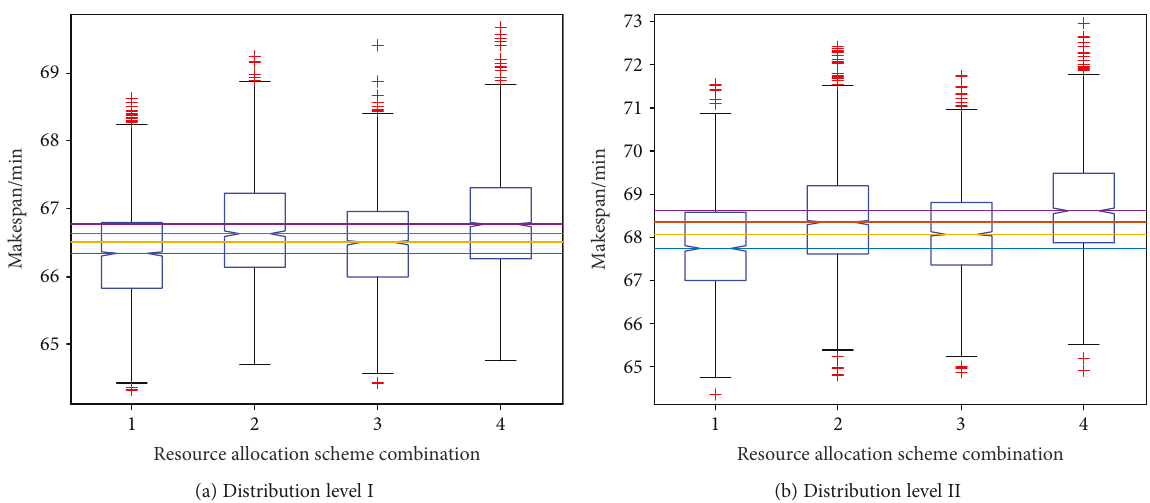
Figure 17: Boxplot of makespan with di ff erent resource allocation scheme combinations (1 for “ C PC -Y-Y ” , 2 for “ C PC -N-Y ” , 3 for “ C PC -Y-N ” , and 4 for “ C PC -N-N ”